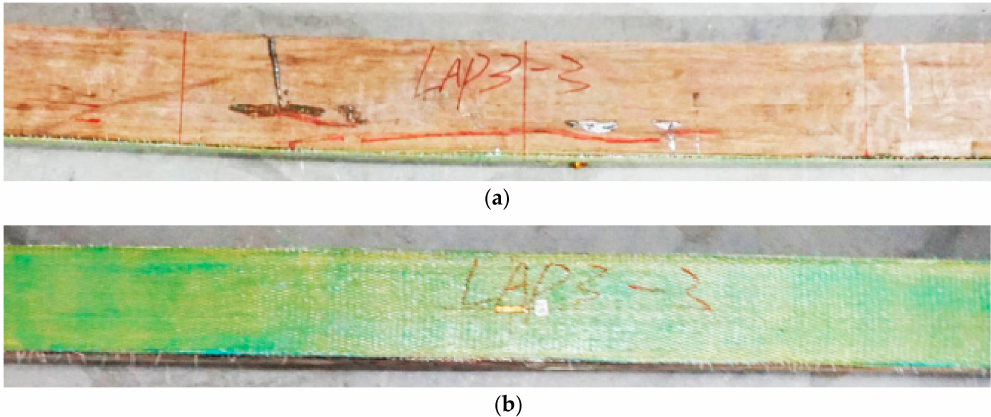
Figure 6. This is the typical failure photos for mode III (LAP3-3): ( a ) side surface; ( b ) bottom